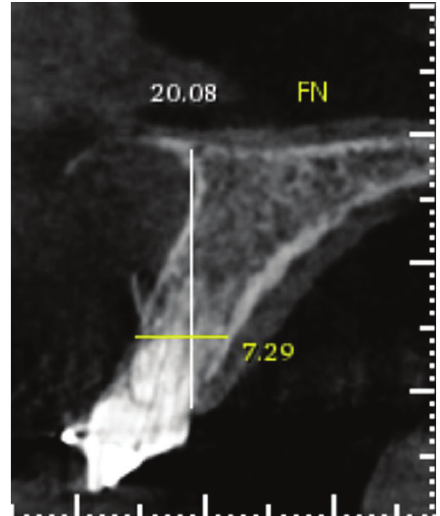
Figure 7: Computed tomography after orthodontic extrusion. Perforation was observed in the